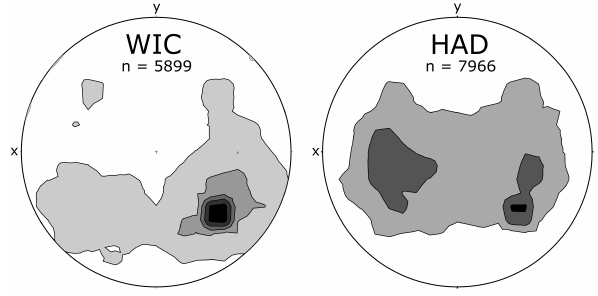
Figure 7. Pore path orientation of sample WIC and HAD using 1% net area contouring with an interval of 1%. WIC shows a strong preferred orientation and a dip of 45 ◦ , which indicates a deviation between x – z plane and bedding plane. Pore paths of HAD show a homogeneous distribution along the bedding